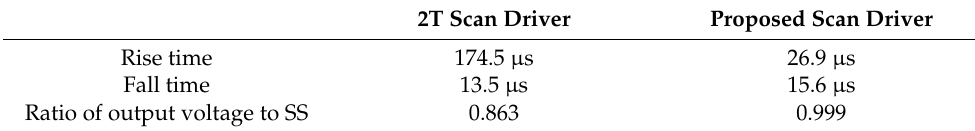
Figure 4. Unit scan drive circuit with two switch TFTs.